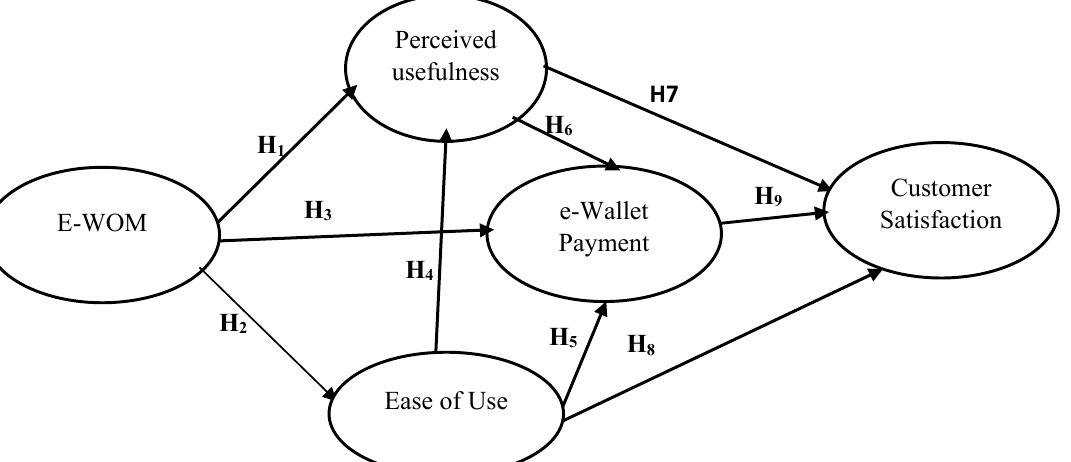
Fig. 1. Framework for the concept of E-WOM research on customer